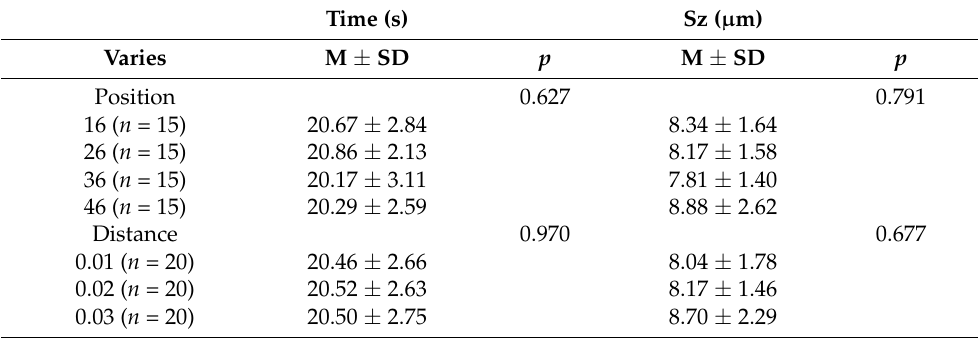
Table 2. Operation time and implant surface wear for multiple drill sleeve distances and positions. Time (s) Varies M ±